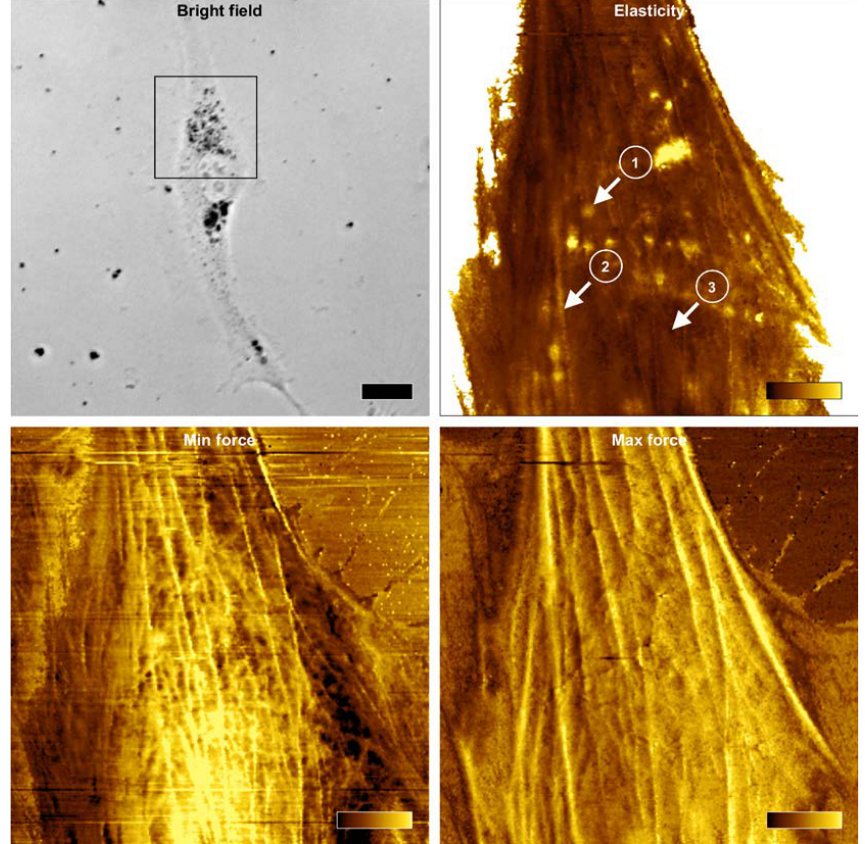
Figure 5. Force maps reconstructed from force curves obtained during PeakForce imaging. Bright field optical microscopy image ( upper left ) of a pigmented BHM cell taken during atomic force microscopy (AFM) analysis. The black frame in the image indicates scan area of 40 × 40 µm 2 covered by AFM. Dark spots in the image are melanin granules. The scale bar for this image represents 20 µm. Elasticity map of the Young’s modulus values ( upper right ) of the cell with three different positions (marked with arrows) from which representative force curves were pulled and are shown in Figure 6. These positions refer to: melanin granule (1), actin bundle (2) and the nucleus (3). The color bar in elasticity map represents values of the Young’s modulus ranging from 0 to 10 kPa (dark-to-bright). Force error maps obtained for two different levels of force: minimum force ( lower left ) and maximum force ( lower right ). Minimum force corresponds to the value of force at the point of contact of the AFM probe with the cell, whereas maximum force corresponds to the maximum force obtained by the probe during indentation (graphically illustrated in Figure 6). Color bars in force error maps represent values of forces ranging from −110 to 50 pN for min force and from 0.4 to 0.6 nN for max force. Note that in the minimum force image, thin filaments are seen in the cortex of a cell, whereas in the maximum force image, thick actin bundles are visible, which are located deeper in the cell. Example force curves pulled from elasticity map for three different locations on the cell (Figure 6) also showed that the pointwise modulus data differed significantly between the positions. For a